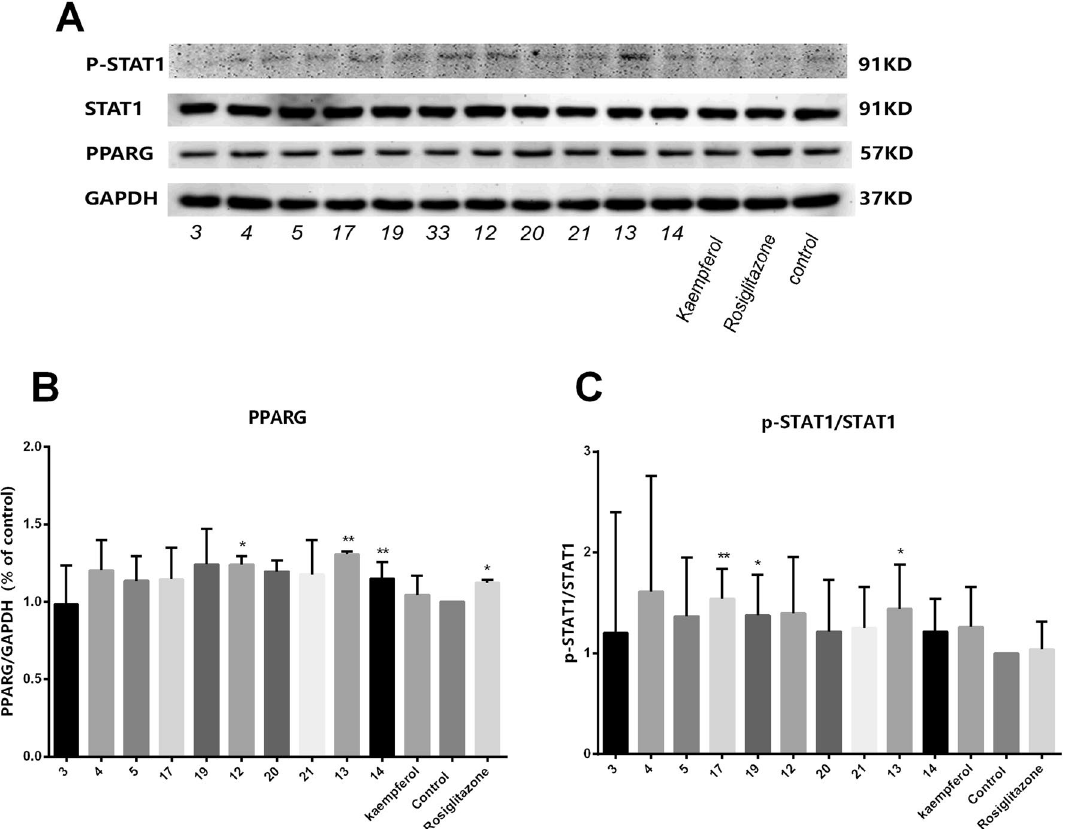
Figure 7. The flavonoids of SCST treated for 24 h at 50 µM altered the protein expression of PPARG, p-STAT1, and STAT1 in activated LX-2 cells. ( A ) Representative Western blots showing the effects of the flavonoids of SCST on the expression of PPARG, p-STAT1, and STAT1, with GAPDH used as the loading control. ( B ) The protein expression levels of PPARG in each group ( n = 4). ( C ) The ratio of p-STAT1/STAT1 in each group ( n = 3). Mean values ± SD are presented. ** P < 0.01 vs . the control group, * P < 0.05 vs . the control